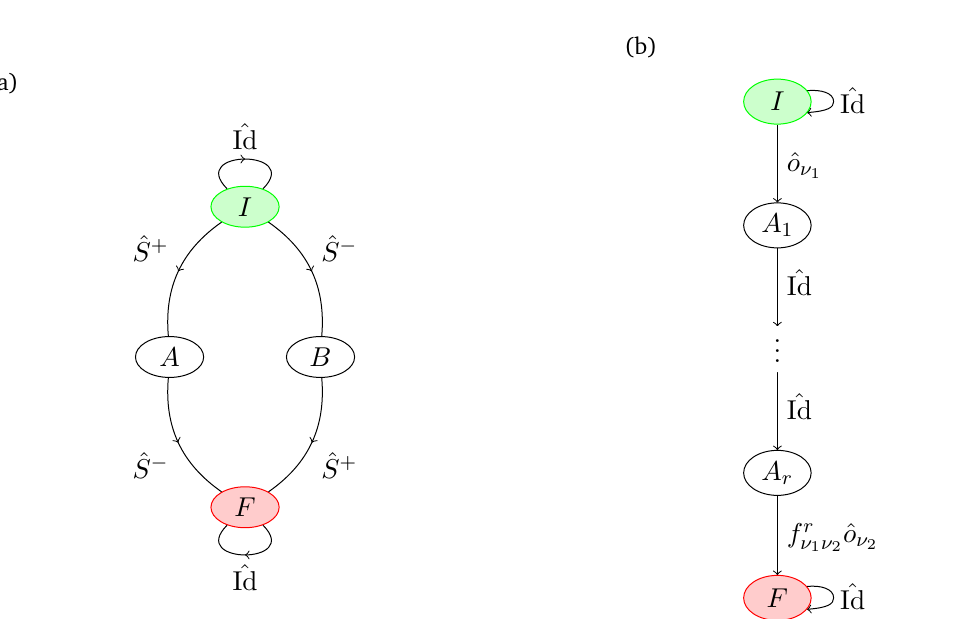
+ h.c.. (b) = (cid:80) ˆ S − ˆ S + XX ( i + 1 ) ( i ) i ˆ o ( i ) ˆ o ( i + r ) of ν ν ν ν 1 2 1 2